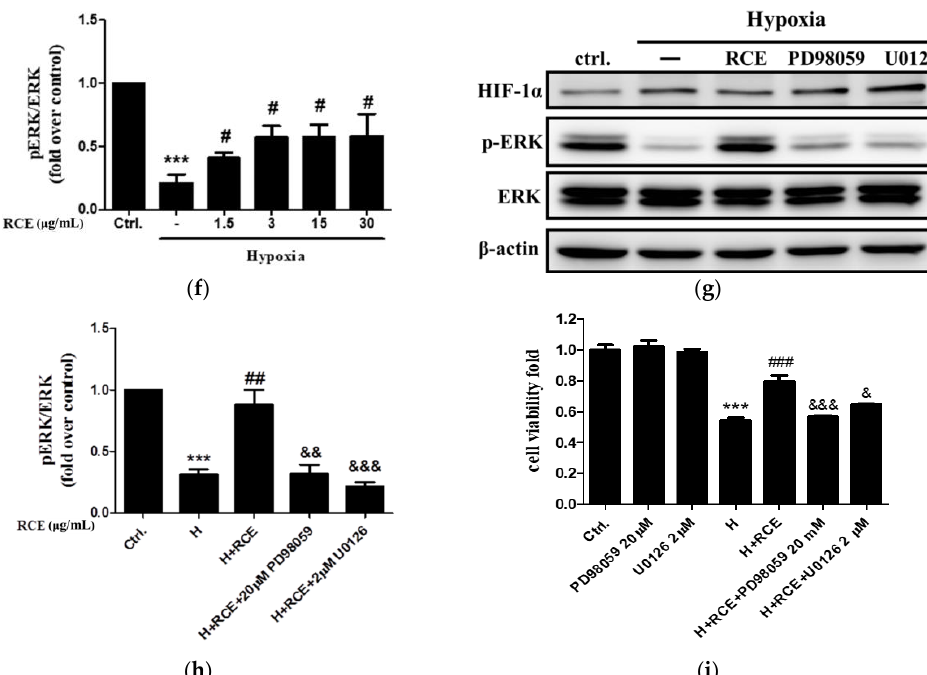
Figure 5. Effect of Rhodiola crenulata root extract on hypoxia-induced endothelial cell apoptosis and extracellular signal-regulated kinase 1/2 (ERK1/2) signaling pathway. After exposure to hypoxia (1% O 2 ) for 24 h with or without RCE treatment, the protein levels of PARP, caspase-3, -8 ( a ), and p-ERK/ERK ( e ) were analyzed by Western blotting. The quantitative analysis of cleaved PARP ( b ), cleaved caspase-8 ( c ), cleaved caspase-3 ( d ), and p-ERK/ERK ( f ) were conducted. The cells were further treated with ERK inhibitor (PD98059 20 μM or U0126 2 μM) for 30 min, followed by incubation with RCE (3 μg/mL) and exposed to hypoxia (1% O 2 ). The effects of ERK inhibitors on p-ERK/ERK ( g , h ) and cell viability ( i ) were determined. Results represent the mean ± SEM ( = 3). * p < 0.05, ** p < 0.01, and *** p < 0.001 versus control; # p < 0.05, ## p < 0.01, and ### p < 0.001 versus hypoxia; & p < 0.05, && p < 0.01, and &&& p < 0.001 versus hypoxic condition with RCE.